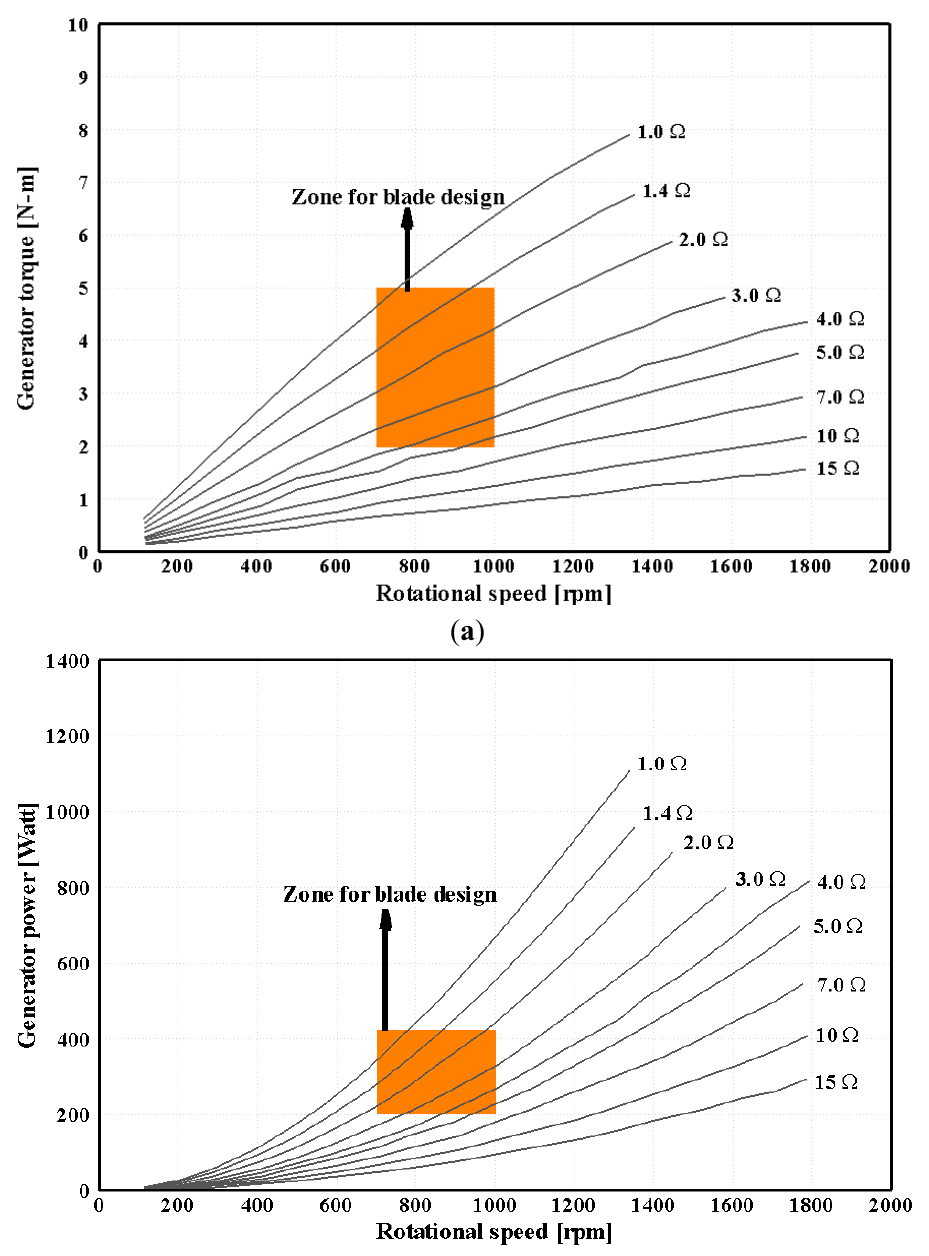
Figure 5. Results of AFPM generator at different rotational speeds for ( a ) torque; ( b ) power; and ( c )